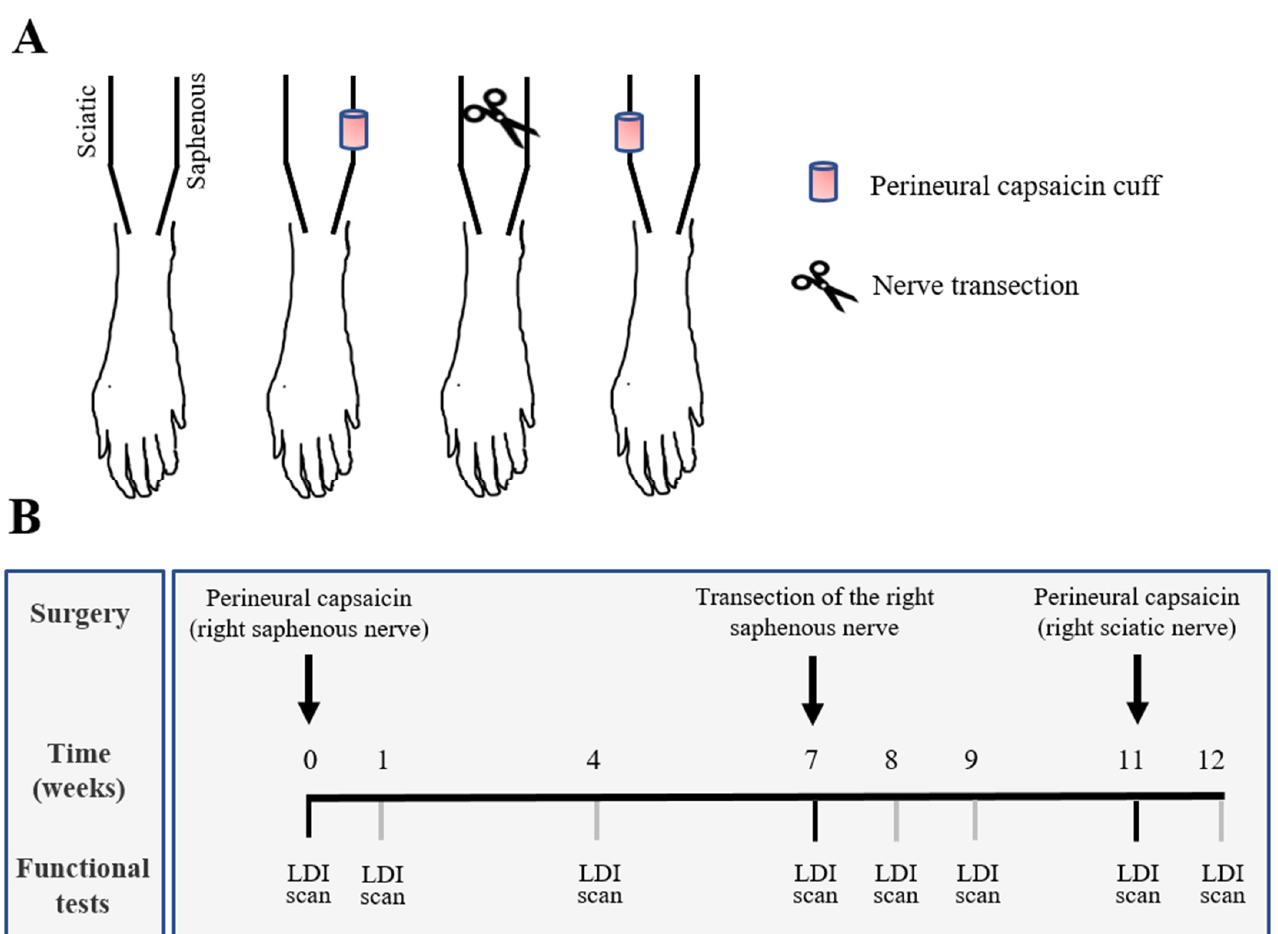
Figure 1. ( A ) Schematic illustration of the types and sequence of surgical interventions applied in this study. ( B ) Timeline of the experiments illustrating the sequence of surgical interventions and functional testing with laser Doppler imaging (LDI) following perineural capsaicin treatment of the saphenous nerve.